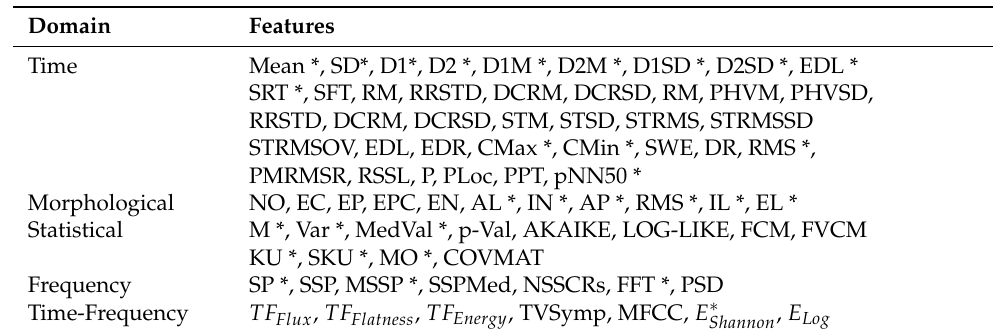
Table 3. Features obtained in the